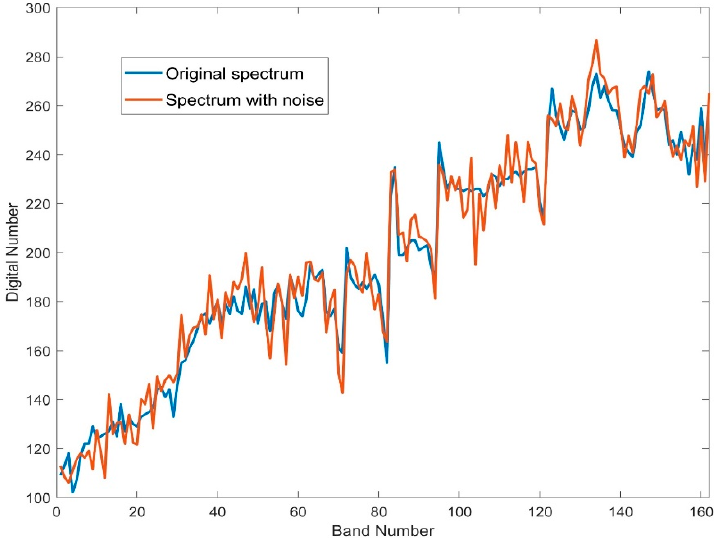
Figure 4. Comparison of the spectral curves of the original and noisy in Urban data.